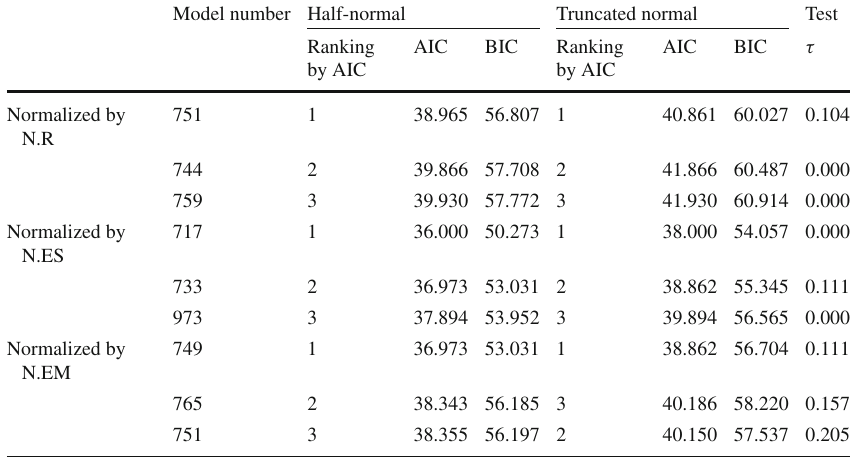
Table 2 Model selection using AIC and BIC Model number Half-normal Truncated normal Test Ranking AIC BIC Ranking AIC BIC τ by AIC by AIC